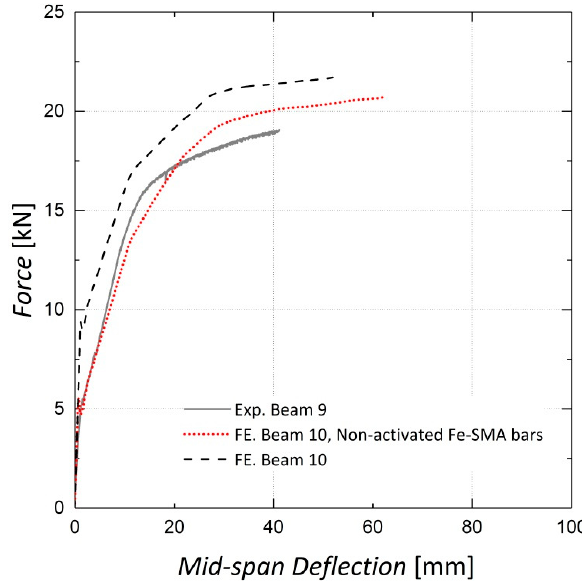
Figure 21. E ff ect of strengthening with activated and non-activated Fe-SMA bars—Beam Figure 21. Effect of strengthening with activated and non-activated Fe-SMA bars—Beam 10. Table 2. Comparison of beams strengthened with activated and non-activated Fe-SMA bars.